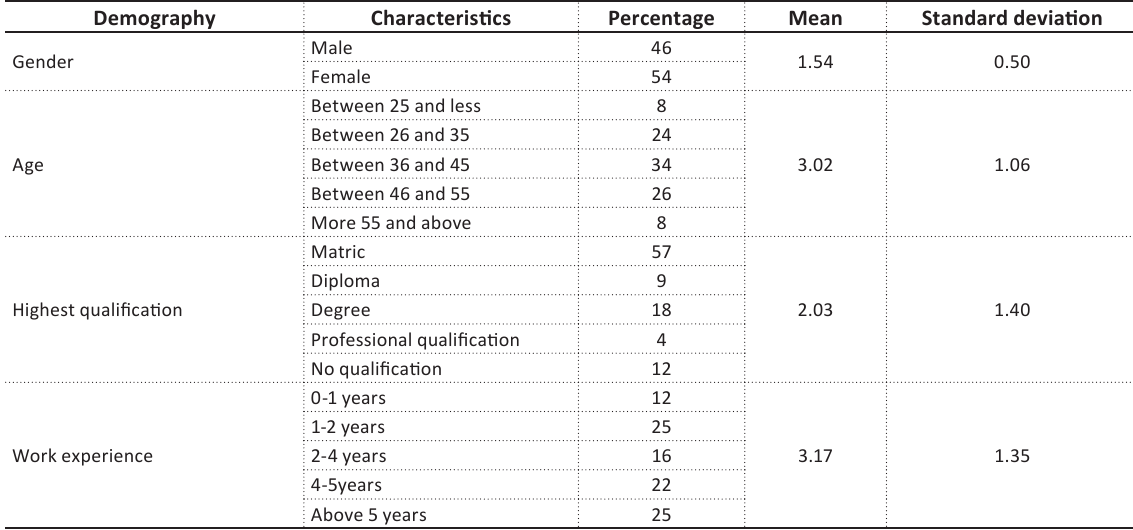
Table 3. Descriptive statistics of demographic variables